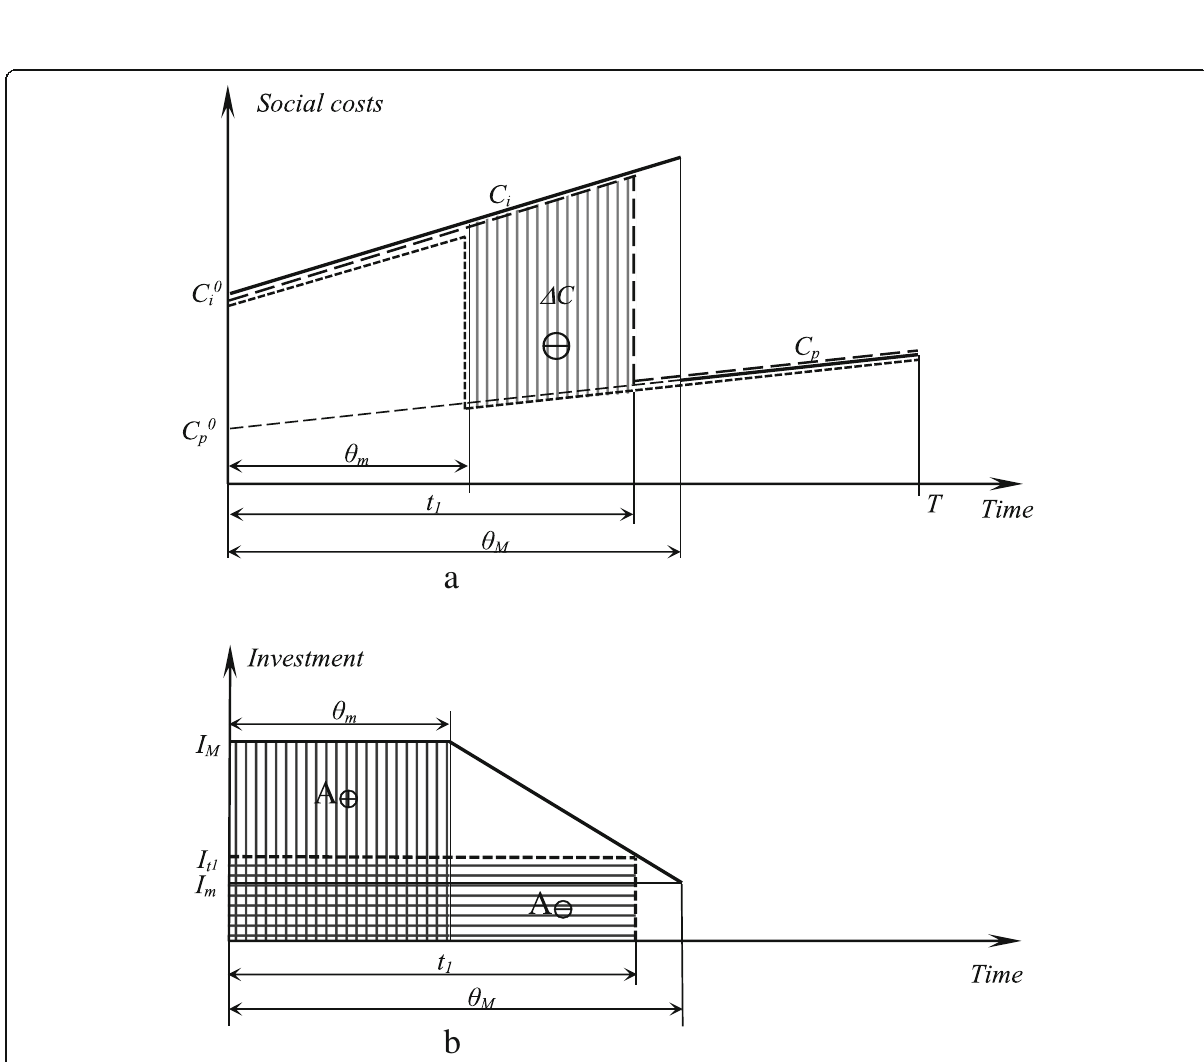
b Fig. 6 Additional social costs and investment savings due to the extension of work duration until. a ) increasing the additional social cost during the work, Δ C b ) investment savings due to the extension of work duration, Δ E = A ⊕ - A ⊖ t 1 ( θ m ≤ t 1 < θ M